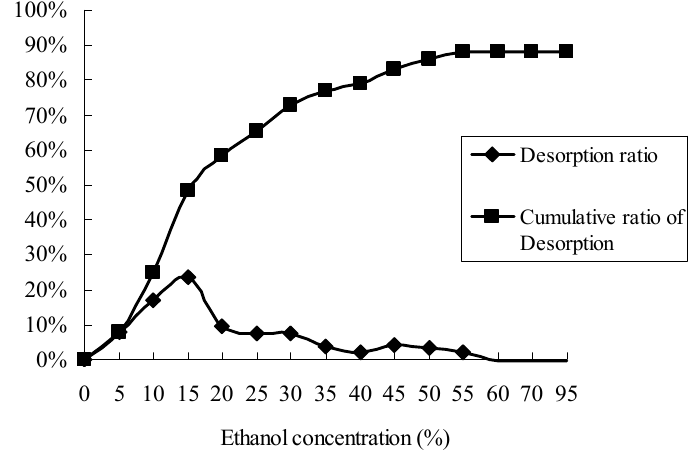
Figure 3. Ratios of desorption and cumulative ratios of desorption for total flavonoids on D402 resin with ethanol-water solutions of different concentrations.